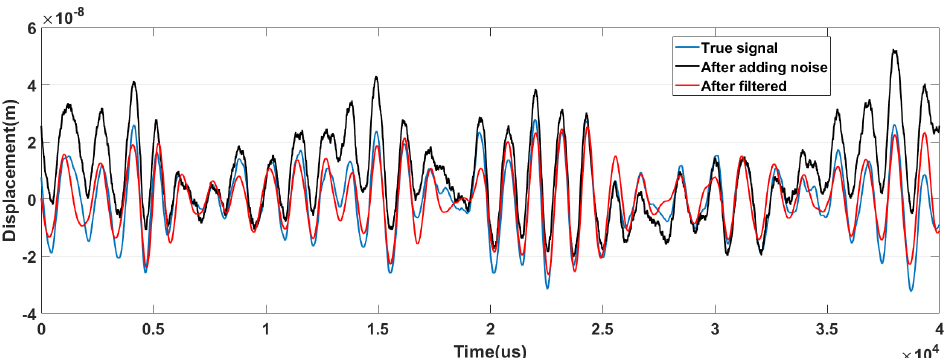
Figure 4. The time domain signal of the particle displacement in the direction of z in the optical trap. The blue line represents the real motion of the particle, the black line represents the noisy signal after the detection module and the red line represents the signal processed by the Kalman